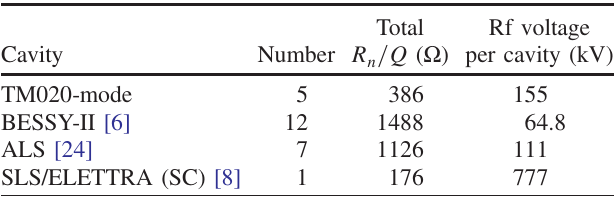
TABLE IV. Parameters of harmonic cavities assumed to esti- mate the voltage fluctuations.